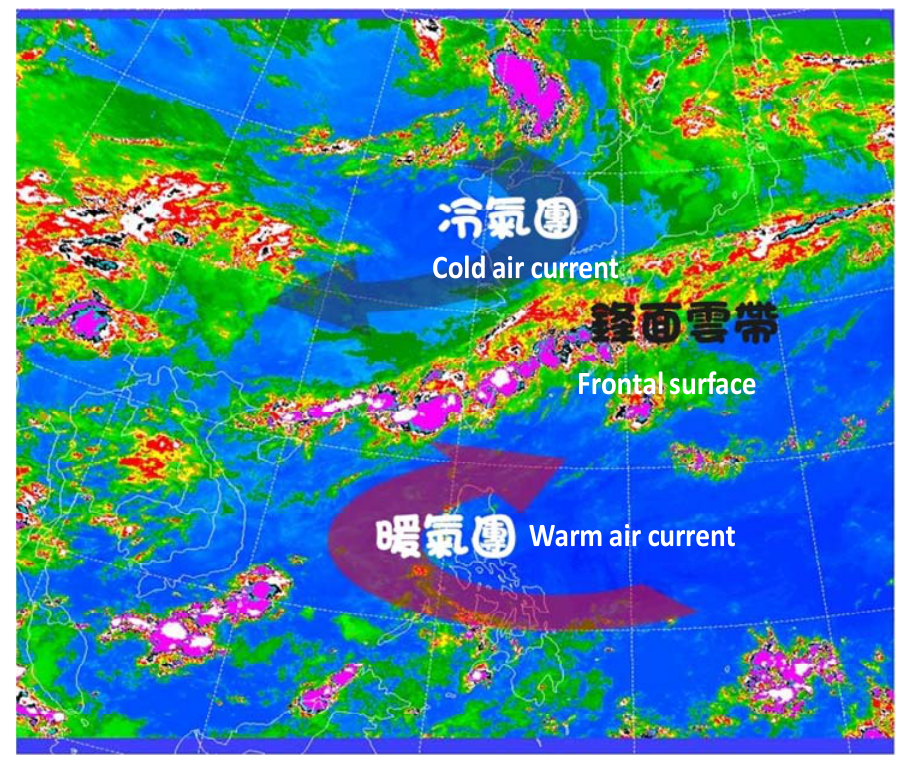
Figure 1. Sketch map of plum rains. Courtesy of the Central Weather Bureau (CWB), Taiwan.